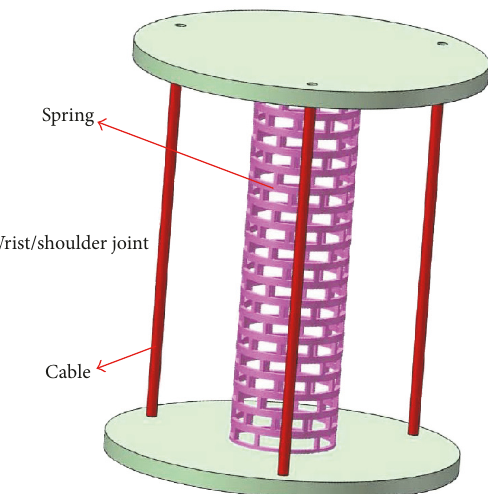
Figure 1: Structure design of the cable-driven wrist/shoulder joint.